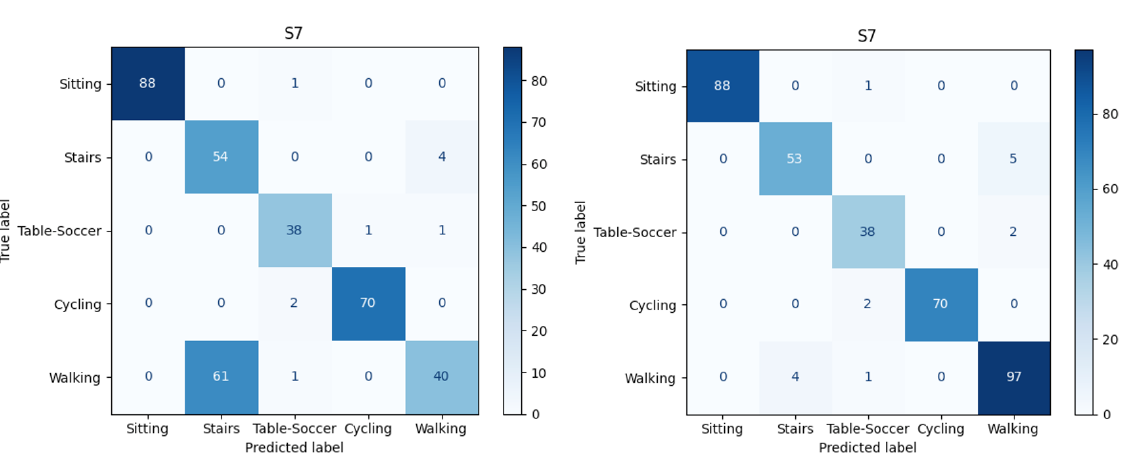
Figure 10. Comparison between confusion matrices in cross-subject models. On the left : the model performance when considering only 3D-ACC. On the right : the model performance when combining 3D-ACC with the ECG